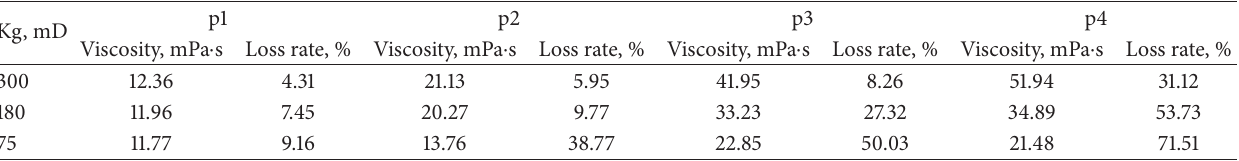
Table 2: Viscosity and its loss rate in the produced liquid with 4 kinds.